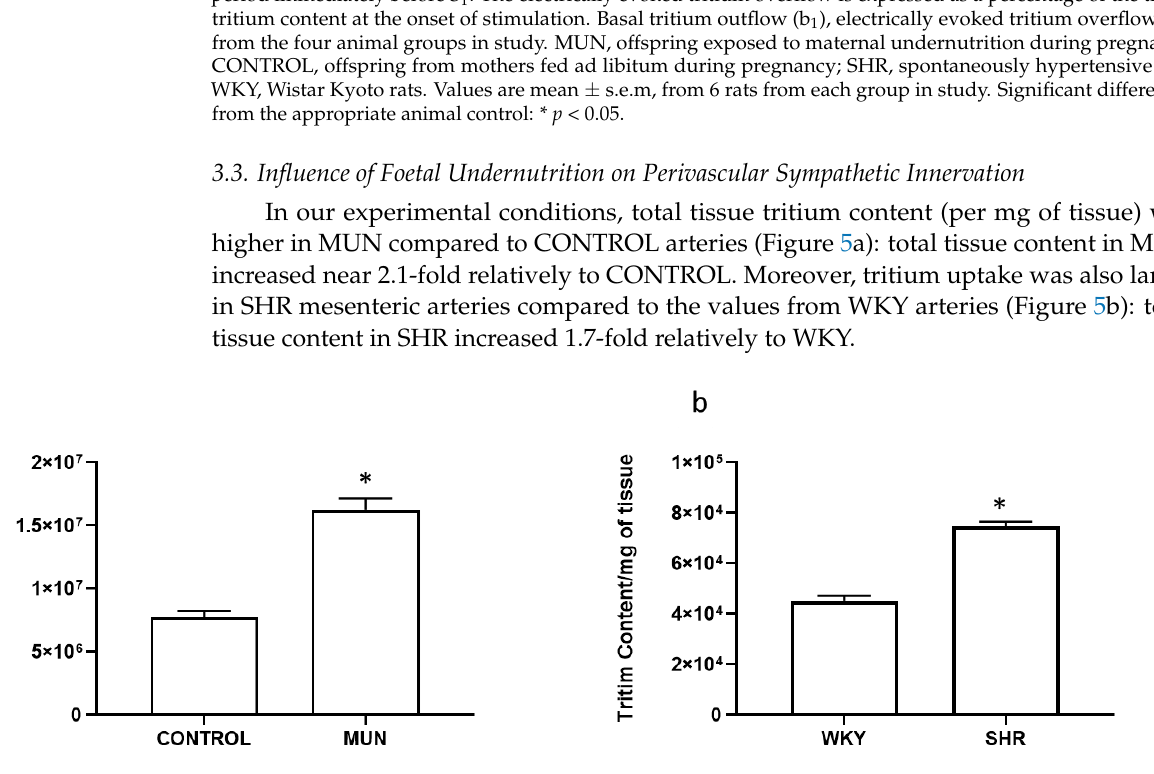
Figure 5. [ 3 H]-Tritium uptake in mesenteric arteries from ( a ) CONTROL and MUN and ( b ) WKY and SHR rats. MUN, offspring exposed to maternal undernutrition during pregnancy; CONTROL, offspring from mothers fed ad libitum during pregnancy; SHR, spontaneously hypertensive rats; WKY, Wistar Kyoto rats. Values are mean ± s.e.m. from 6 animals per group. Significant differences from the respective control rats: * p < 0.05.